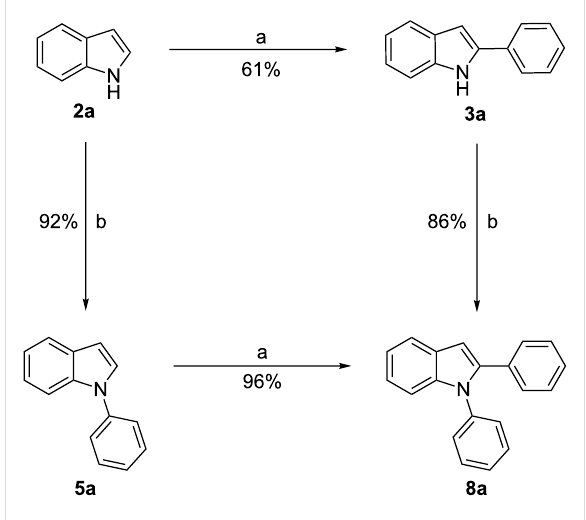
Scheme 6: Routes towards 1,2-diarylindoles starting from indole; a: PhB(OH) 2 (3 equiv), Pd(OAc) 2 (5 mol %), AcOH, O 2 , rt, 12 h; b: